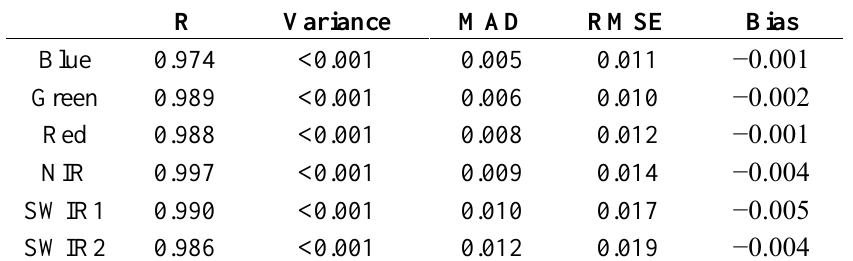
Table 10. Accuracy assessment result with no consideration of land cover change